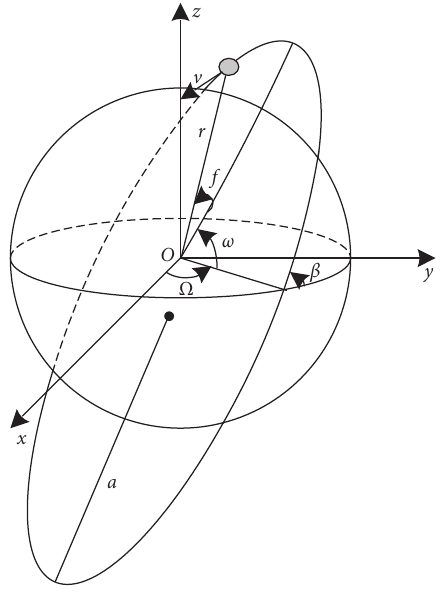
Figure 1: The schematic of the orbital elements in the ECI